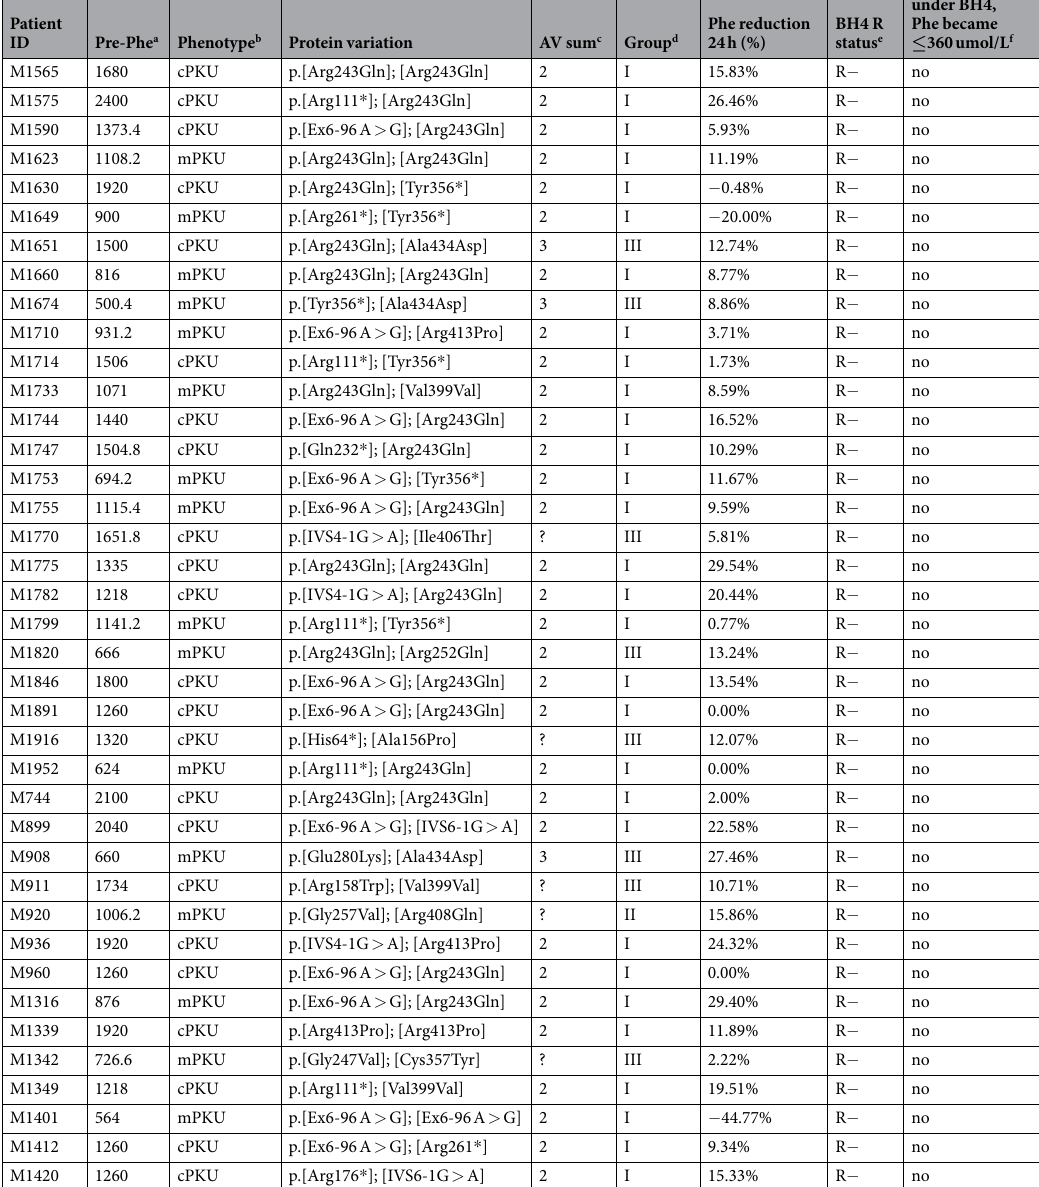
Table 1. BH4 loading test in 94 Chinese PAH Deficient patients. a The highest plasma Phe concentration (umol/L)before treatment, and all of which applied in this study were the maximum pretreatment values. b Phenotypes were stratified as mild hyperphenylalaninemia (MHP), mild phenylketonuria (mPKU), and classical PKU (cPKU) based on the pretreatment plasma Phe values. c An arbitrary value (AV) if available was assigned to each mutation: AV = 1 for classical PKU mutation; AV = 2 for moderate PKU mutation; AV = 4 for mild PKU mutation, and AV = 8 for MHP mutation. Phenotypes resulting from a combination of the two mutant alleles were expressed as the sum of the two mutations’ AVs. d The groups for the patients based on the assessment of the BH4-responsiveness-status of the detected mutations. I for “Non BH4 responsive”; II for “BH4 responsive”; III for “Undefined BH4 responsive”. e Based on BH4 loading test; R: response; R + : responder; R − :